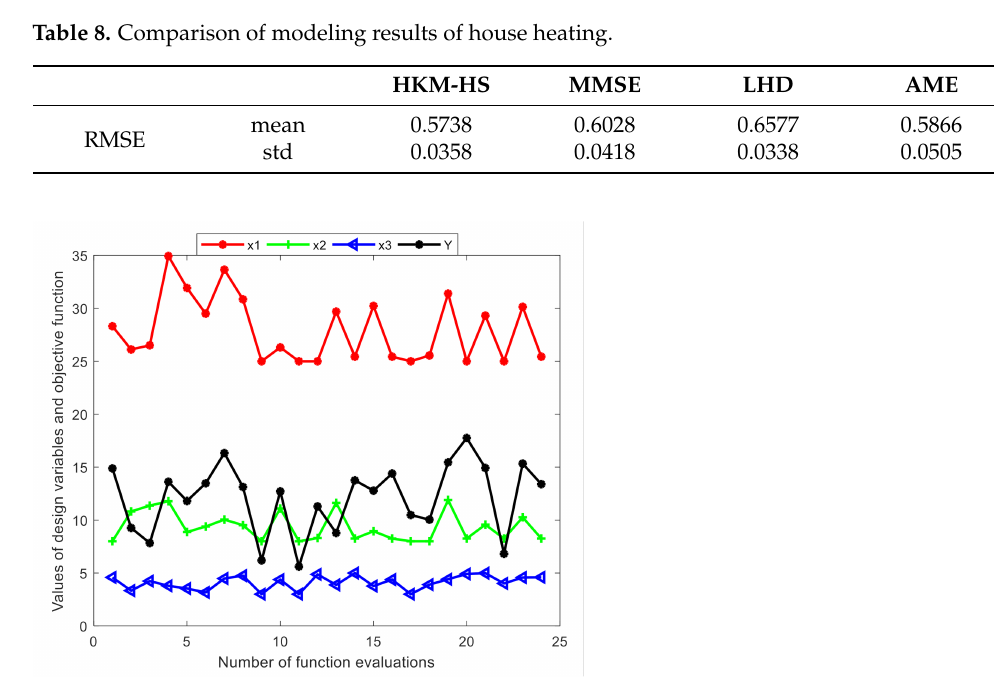
Figure 20. Trends of design variables x 1 , x 2 , x 3 and objective function obtained by